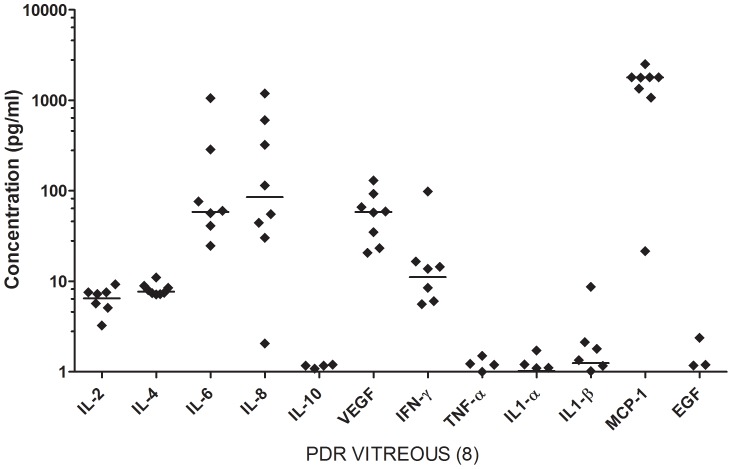
Scatter plot showing the distribution levels of 12 cytokines in vitreous from PDR (n = 8) patients, quantified using cytokine bio-chip array.Each sample represents the mean of duplicates. Solid line indicates the median. PDR-Proliferative diabetic retinopathy; ED- Eales' disease. IL - Interleukins, VEGF- Vascular endothelial growth factor, IFN-γ- Interferon gamma, TNF-α - Tumour necrosis factor alpha, MCP-1 - Monocyte chemoattractant protein-1, EGF - Epidermal growth factor.